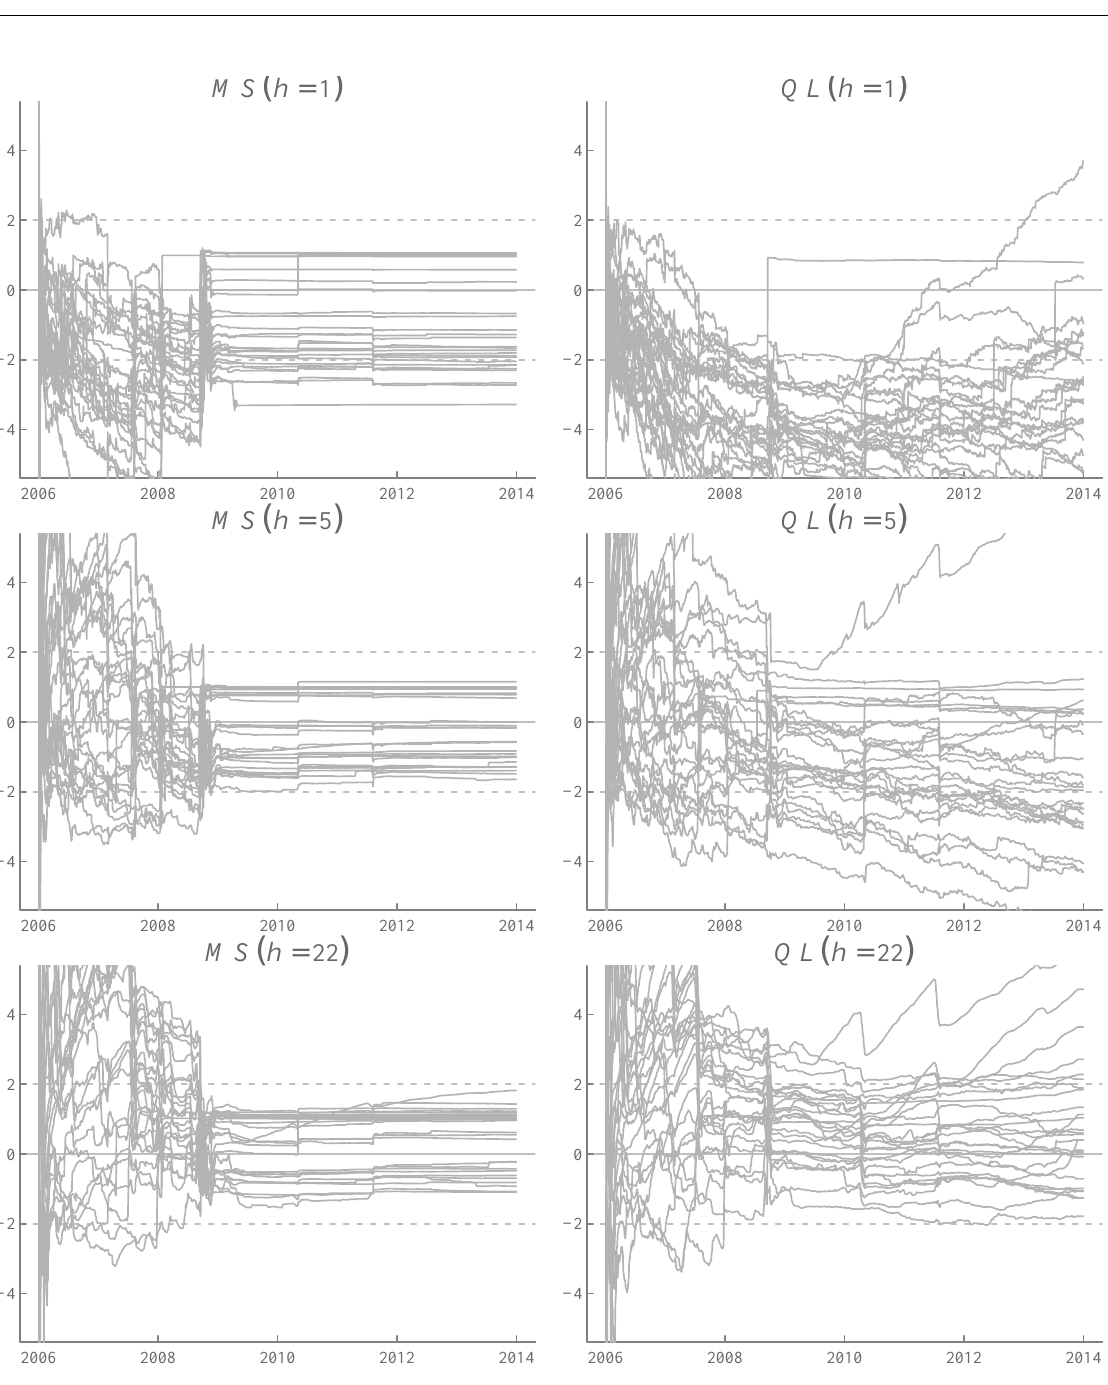
Figure A7. Running t -ratios of Diebold and Mariano [27] test of equal predictive accuracy of h -step RV rolling forecasts. Each panel has 27 lines for the 27 stocks in the sample. The baseline forecast is from the HARQ model (no transformation) and the comparison forecast is the exponential transform of the log forecast from model (Section 3.1) adjusted with a smearing factor [25]. A positive value indicates better forecast from the comparison model against the baseline HARQ forecasts. MS for equality of mean squared error loss and QL for QLIKE loss of Patton [24]. The rolling forecasts are generated with a rolling estimation window of 8.67 years (104 months) followed by a one month prediction window shifted each month over 96 windows. The forecast sample is from 3 January 2006 to 31 December 2013 (2013 trading